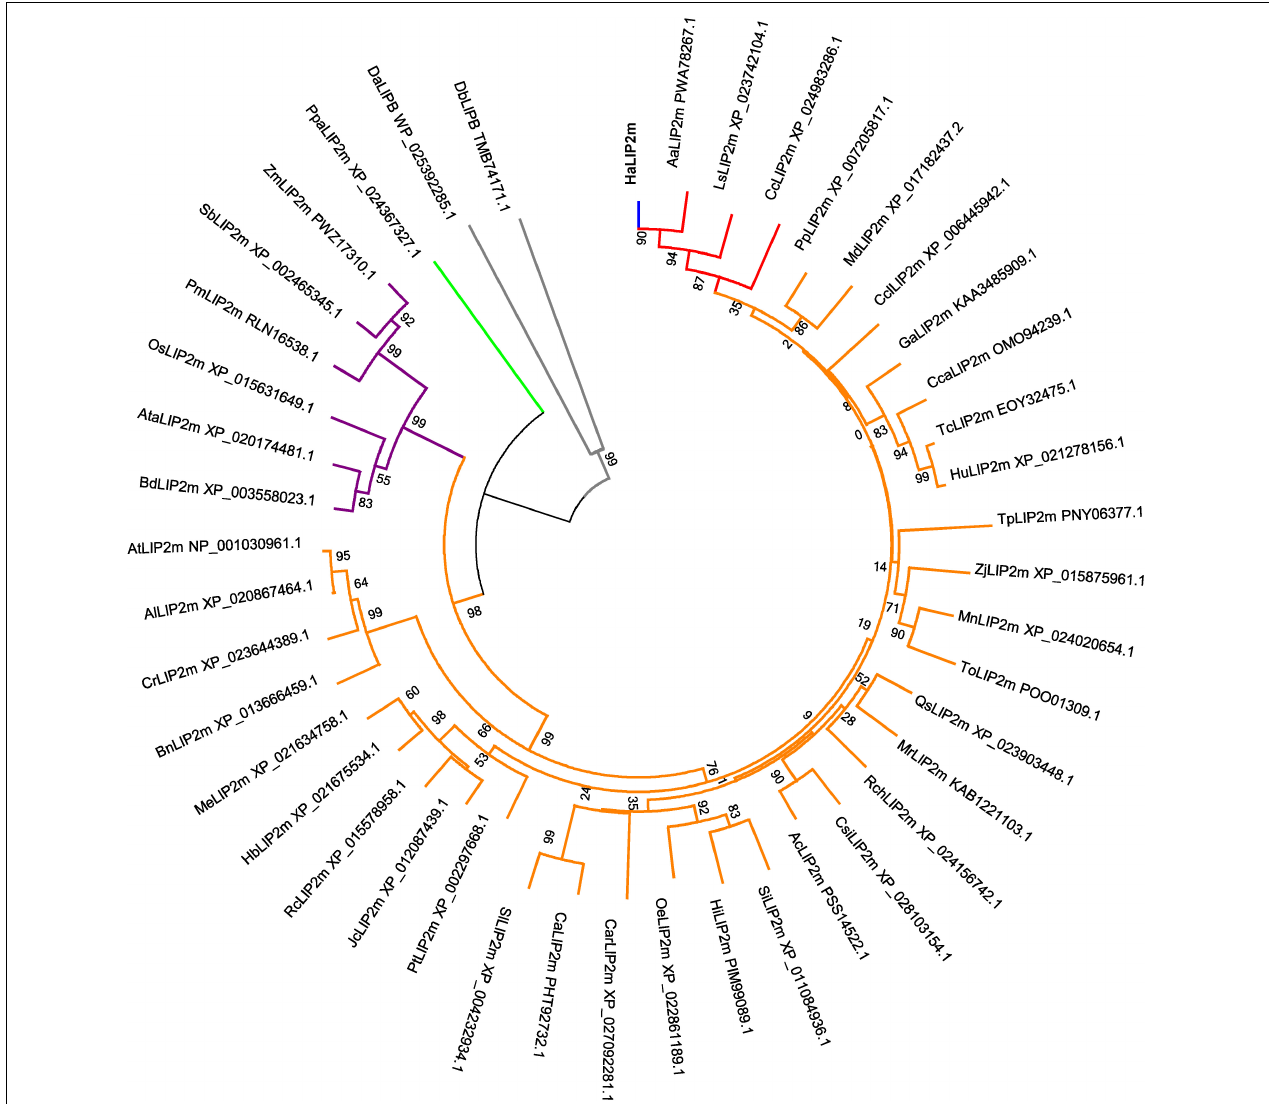
FIGURE 2 | Phylogenetic tree of the annotated mitochondrial octanoyltransferases. Plant species included are: Aa, Artemisia annua; Ac, Actinidia chinensis; Al, Arabidopsis lyrata; At, Arabidopsis thaliana; Ata , Aegilops tauschii; Bd, Brachypodium distachyon; Bn, Brassica napus; Ca, Capsicum annuum; Car, Coffea Arabica; Cc, Cynara cardunculus; Cca, Corchorus capsularis; Ccl, Citrus clementine; Cr, Capsella rubella; Csi, Camellia sinensis; Ga, Gossypium austral; Ha, Helianthus annuus; Hb, Hevea brasiliensis; Hi, Handroanthus impetiginosus; Hu, Herrania umbratica; Jc, Jatropha curcas; Ls, Lactuca sativa; Md, Malus domestica; Me, Manihot esculenta; Mn, Morus notabilis; Mr, Morella rubra; Oe, Olea europaea; Os, Oryza sativa ; Pm, Panicum miliaceum; Pp, Prunus persica; Pt, Populus trichocarpa; Qs, Quercus suber; Rc, Ricinus communis; Rch, Rosa chinensis; Sb, Sorghum bicolor; Si, Sesamun indicum; Tc, Theobroma cacao; To, Trema orientale; Tp, Trifolium pratense; Sl, Solanum lycopersicum; Zj, Ziziphus jujuba; Zm, Zea mays. LIP2m from a bryophyte (Ppa, Physcomitrella patens) was used as an outgroup (green subtree), and Ha LIP2m is marked in blue, the Asteraceae family in red the dicots in orange, the monocots in purple and two proteobacteria species in gray (Da, Desulfurella acetivorans and Db, Deltaproteobacteria bacterium